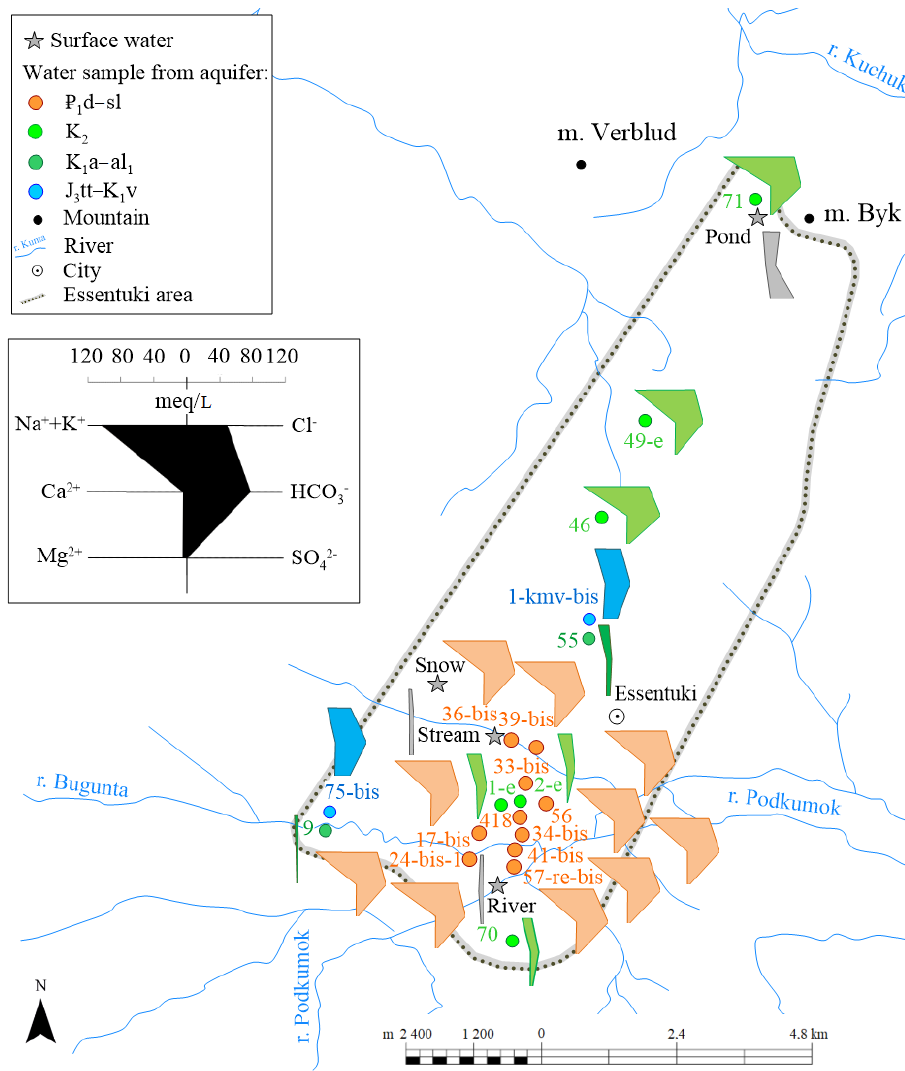
Figure 3. Stiff diagrams showing the chemical composition of natural mineral water of the Essentuki field.